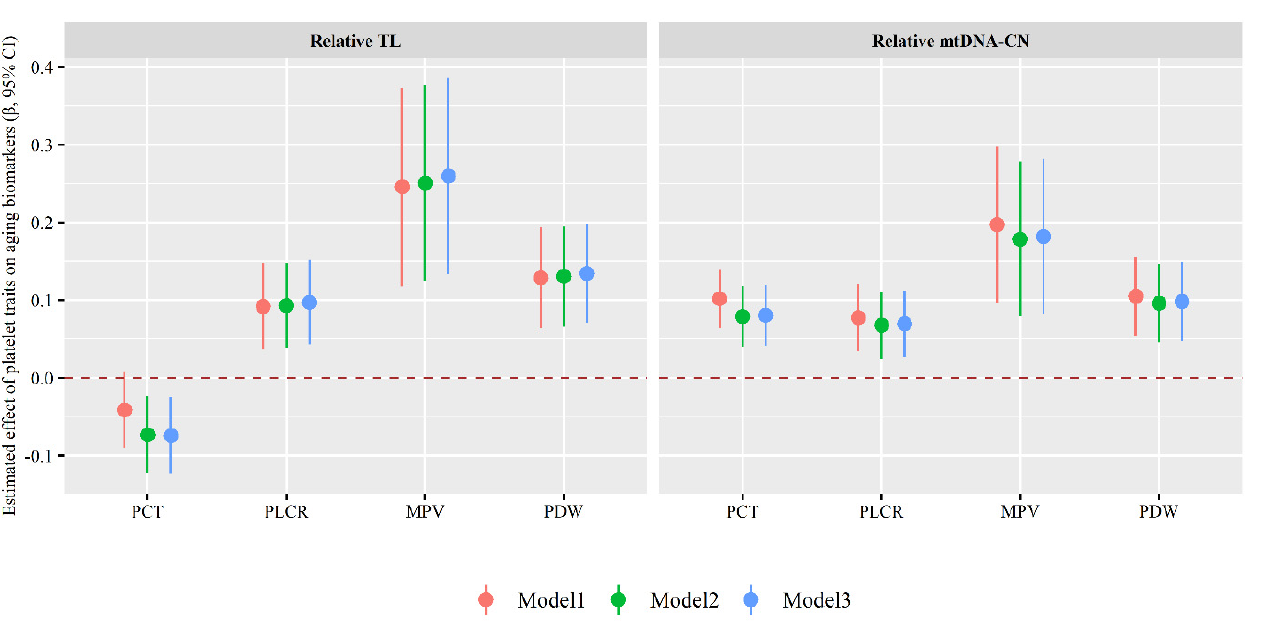
Figure 4. Associations of platelet traits with aging biomarkers. Model 1 was the crude model; Model 2 was adjusted for individuals’ demographic characteristics (such as age, sex, personal average monthly income, marital status, and educational attainment) and lifestyle behavior (such as physical activity, drinking and smoking status, vegetable and fruit intake, and high fat diet); Model 3 was an additional adjustment of hypertension, type 2 diabetes mellitus, dyslipidemia, and family histories of diseases including hypertension, hyperlipidemia, or diabetes. MPV: mean platelet volume; mtDNA-CN: mitochondrial DNA copy number; PCT: plateletcrit; P-LCR: platelet large cell ratio; PDW: platelet distribution width; TL: telomere